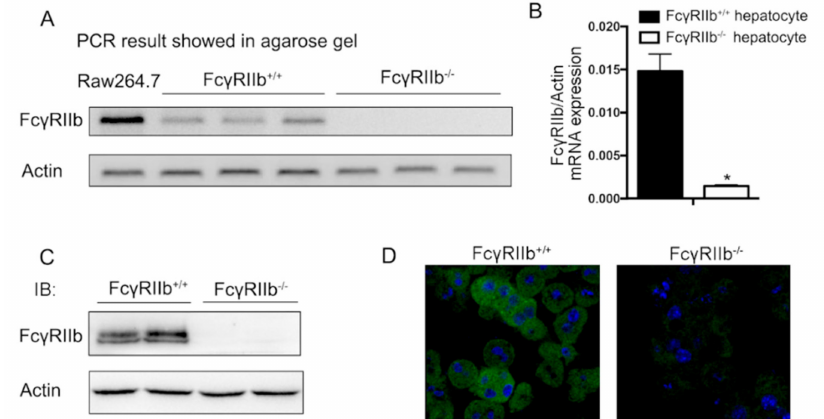
Figure 1. Expression of Fc γ RIIb in hepatocytes. Primary cultured mouse hepatocytes were isolated from Fc γ RIIb +/+ and Fc γ RIIb − / − mice. ( A ) RNA was extracted and RT-PCR was performed using primers designed for amplification of Fc γ RIIb. Macrophage celline RAW264.7 was used as a positive control. ( B ) Fc γ RIIb/actin mRNA expression ratio, detected by qRT-PCR. * p < 0.05, n = 3 ( C ) Western